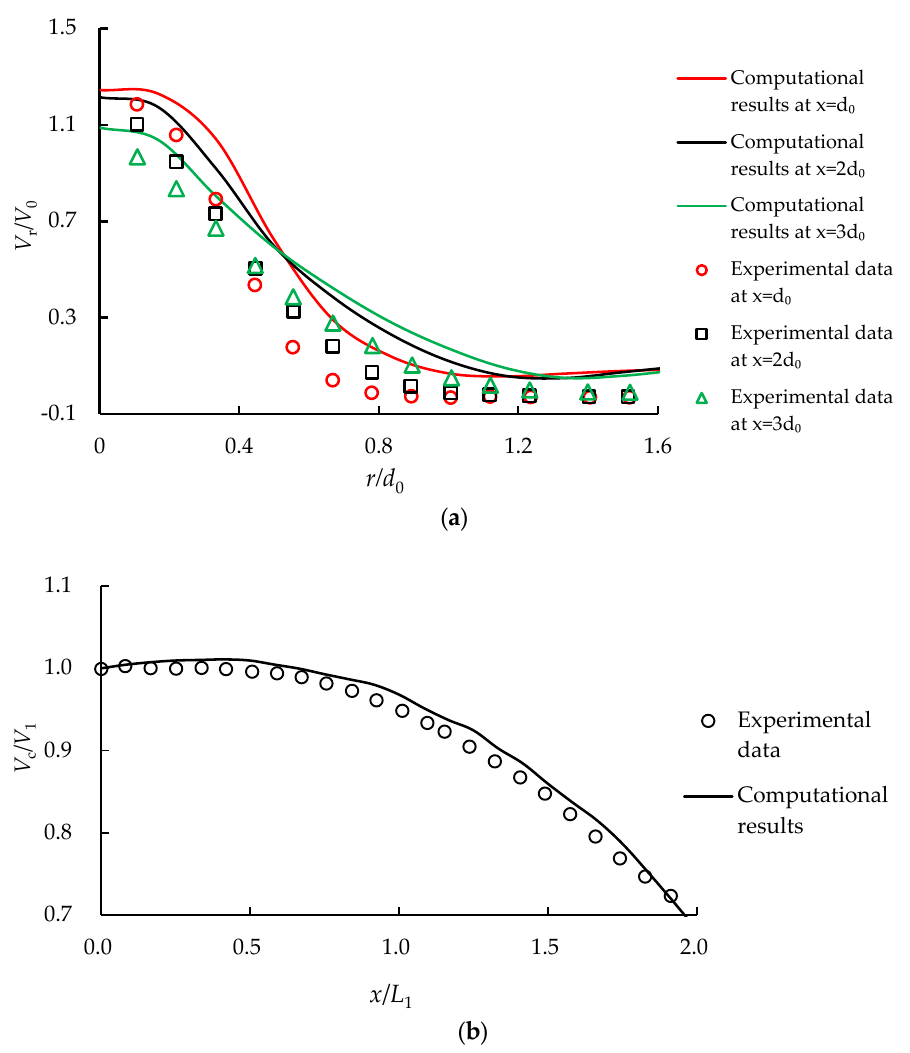
Figure 5. The computational results in comparison to experimental data reported by Qu et al. [5] for ( a ) the V r / V 0 relationship with r/d 0 for different submerged depth scenarios, and ( b ) the V c / V 1 relationship with x / L 1 for V 0 = 0.63 m/s and L 1 = 0.012 m.